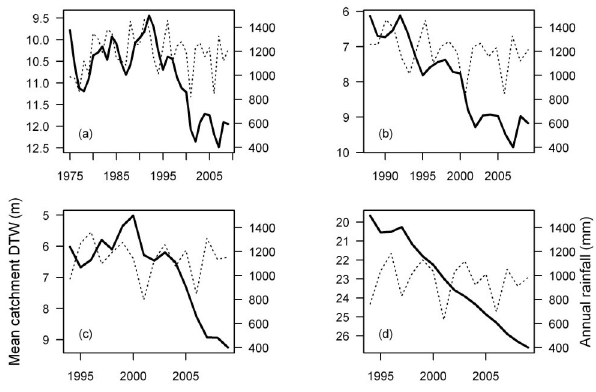
Figure 2. Mean catchment annual depth to groundwater (solid lines) and annual precipitation (dashed lines) for four SWA catch- ments (from Hughes et al., 2012).